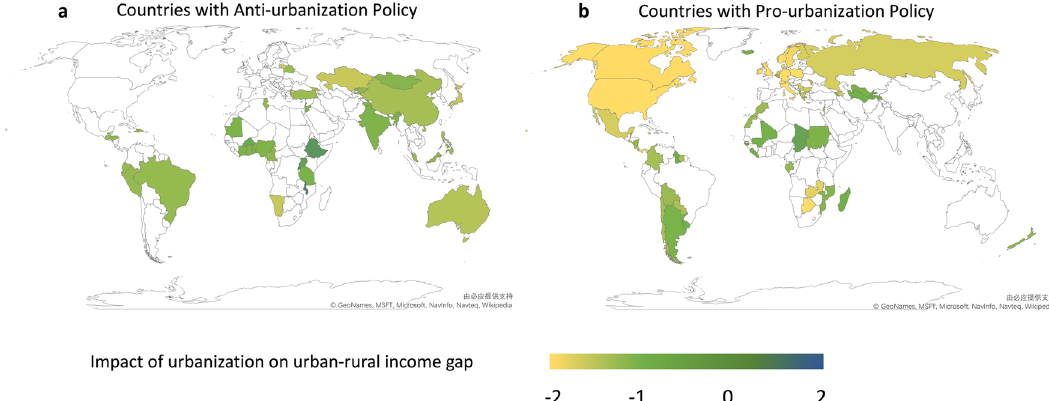
Fig. 5 Urbanization rate and impact of urbanization on the urban-rural gap. This shows that the benign effect kicks in soon after the urbanization rate reaches approximately 30%. Source: Authors ’ calculations (see Methods).